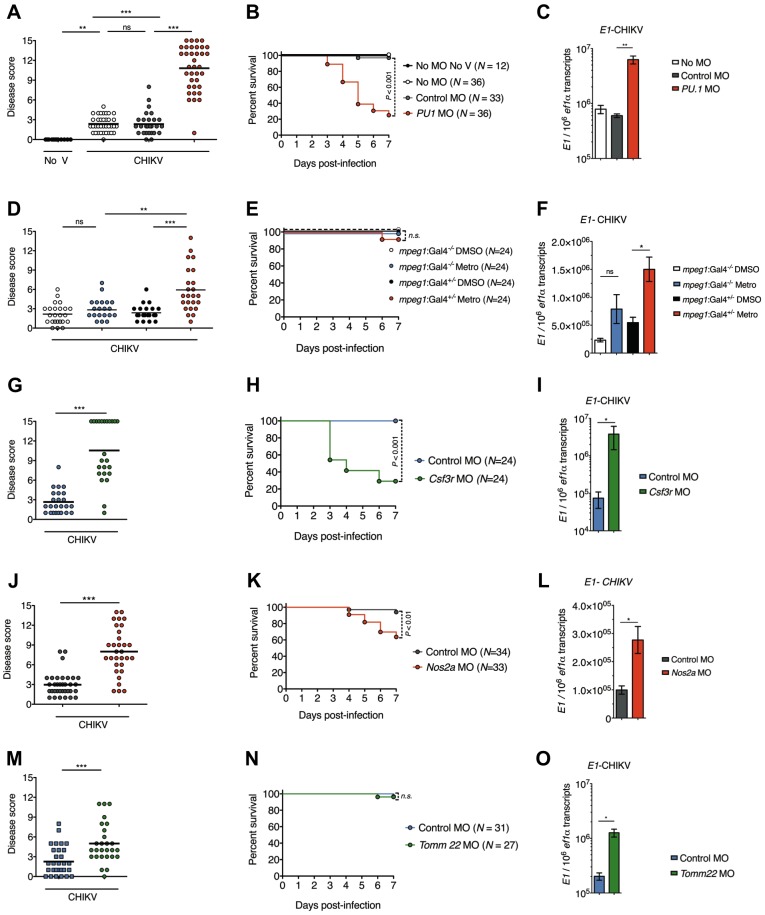
Neutrophils are key ifnφ1-producing cells.(A–C) Effect of myeloid cell depletion (PU.1 MO, 3 independent experiments), (D–F) of macrophage depletion (metronidazole treatment of mpeg1:Gal4/UAS:NfsB-mCherry fish, 2 independent experiments), (G–I) of neutrophil-biased depletion (csf3r MO, 2 independent experiments), (J–L) of impairment of emergency granulopoiesis (nos2a MO, 2 independent experiments) and (M–O) of hepatocyte depletion (Tomm22 MO, 2 independent experiments) on CHIKV infection. (A, D, G, J and M) Disease score at 3 dpi. (B, E, H, K and N) Survival of infected zebrafish. Data pooled from the independent experiments. (C, F, I, L and O) qRT-PCR of viral E1 transcripts at 24 hpi. Mean ± s.e.m of 6 pools of 5 larvae from 2 (C, F, L) or 1 (I, O) independent experiments. (***P < 0.001; **P < 0.01; *P < 0.05; ns - not significant).